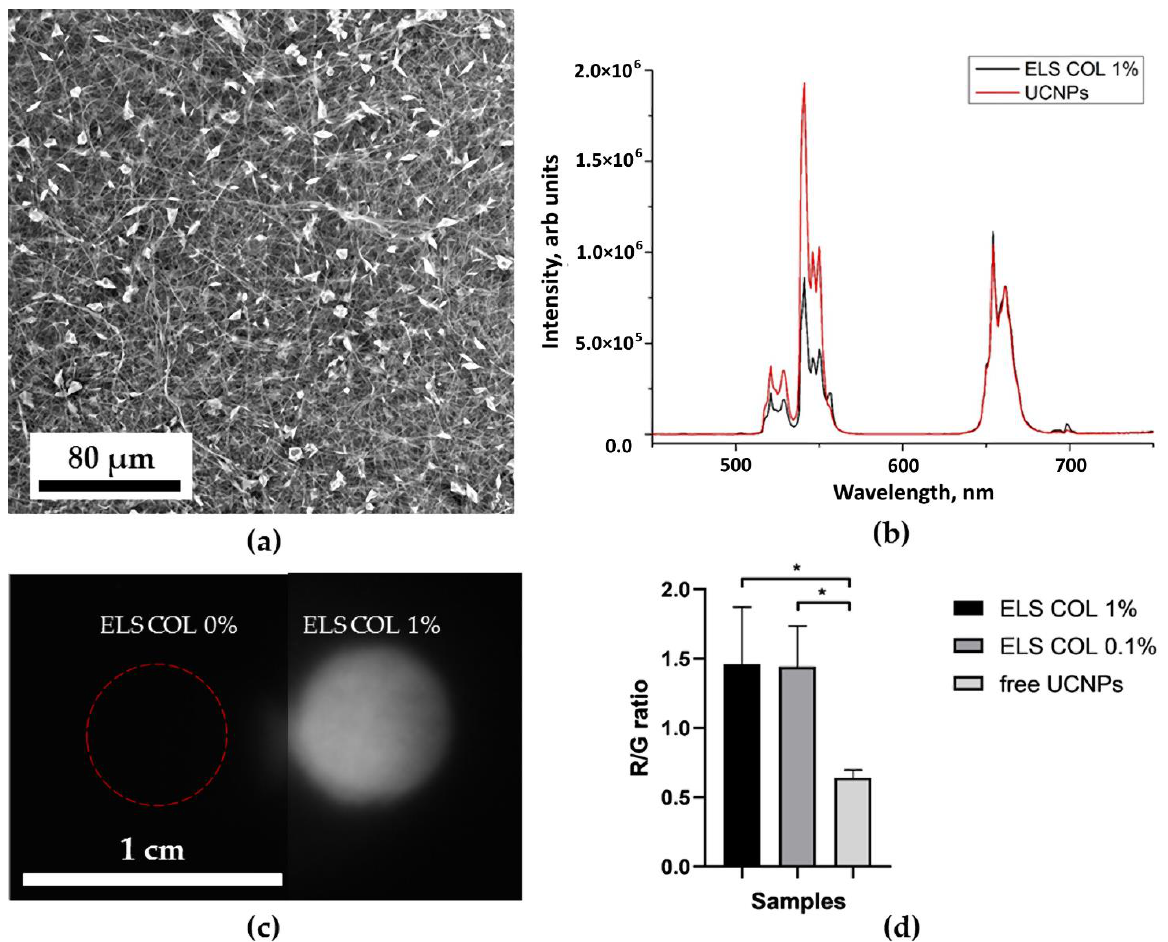
Figure 6. Electrospun collagen scaffold characterization: SEM image ( a ); normalized photoluminescence spectra of the UCNPs and the UCNPs included in ELS COL scaffolds ( b ); photographs of ELS COL scaffolds with 0 (control) and 1 mg of UCNPs per 100 mg of polymer at 976 nm ( c ). Ratio of the intensity of the red peak at 658 nm to the intensity of the green one at a wavelength of 544 nm of UCNPs and ELS COL scaffolds (0.1 and 1% UCNPs) * p < 0.05, ** p < 0.01 in Student ’ s t-test ( d ).